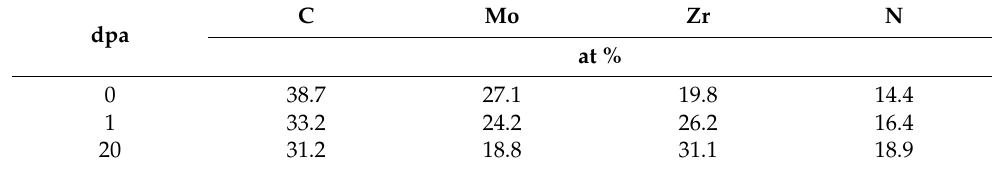
Table 4. Peak proportions of C, Mo, N, and Zr in (Zr, Mo) (C, N) with different irradiation doses. C Mo Zr N dpa at %